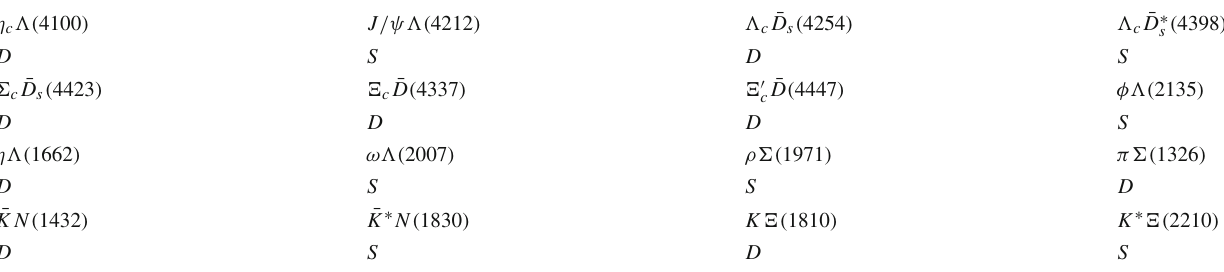
Table 1 Two-body strong decay final states for the P cs ( 4459 ) as a (cid:2) c ¯ D ∗ molecule with I ( J P ) = 0 ( 3 / 2 − ) . Here, the masses for the final states are in the unite of MeV. The S and D stand for the S − wave and D − wave decay modes, respectively η (cid:3)( 4100 c